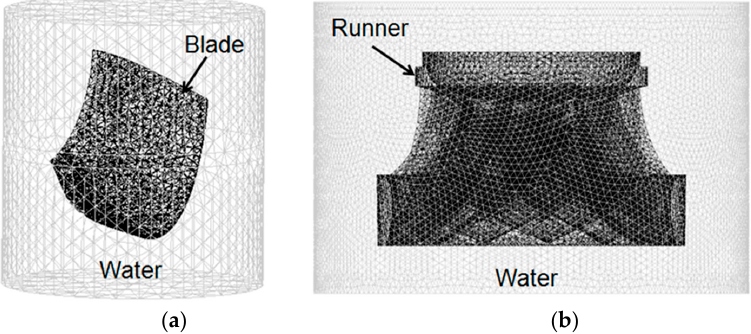
Figure 4. ( a ) Mesh of the single blade and the surrounding water; ( b ) mesh of the entire runner and the surrounding water.